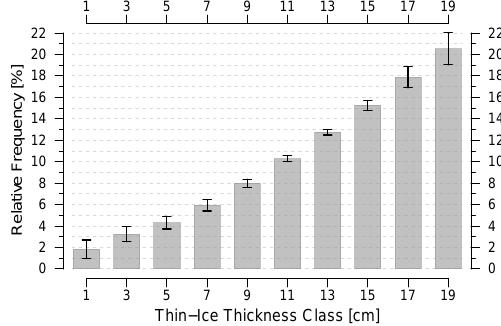
Figure 6. Averaged distribution of thin-ice thicknesses in the south- ern Weddell Sea over the whole 13-year time interval between April and September. The class width is 2cm; i.e., the 1cm class includes thicknesses between 0 and 2cm. Error bars represent ± 1 standard